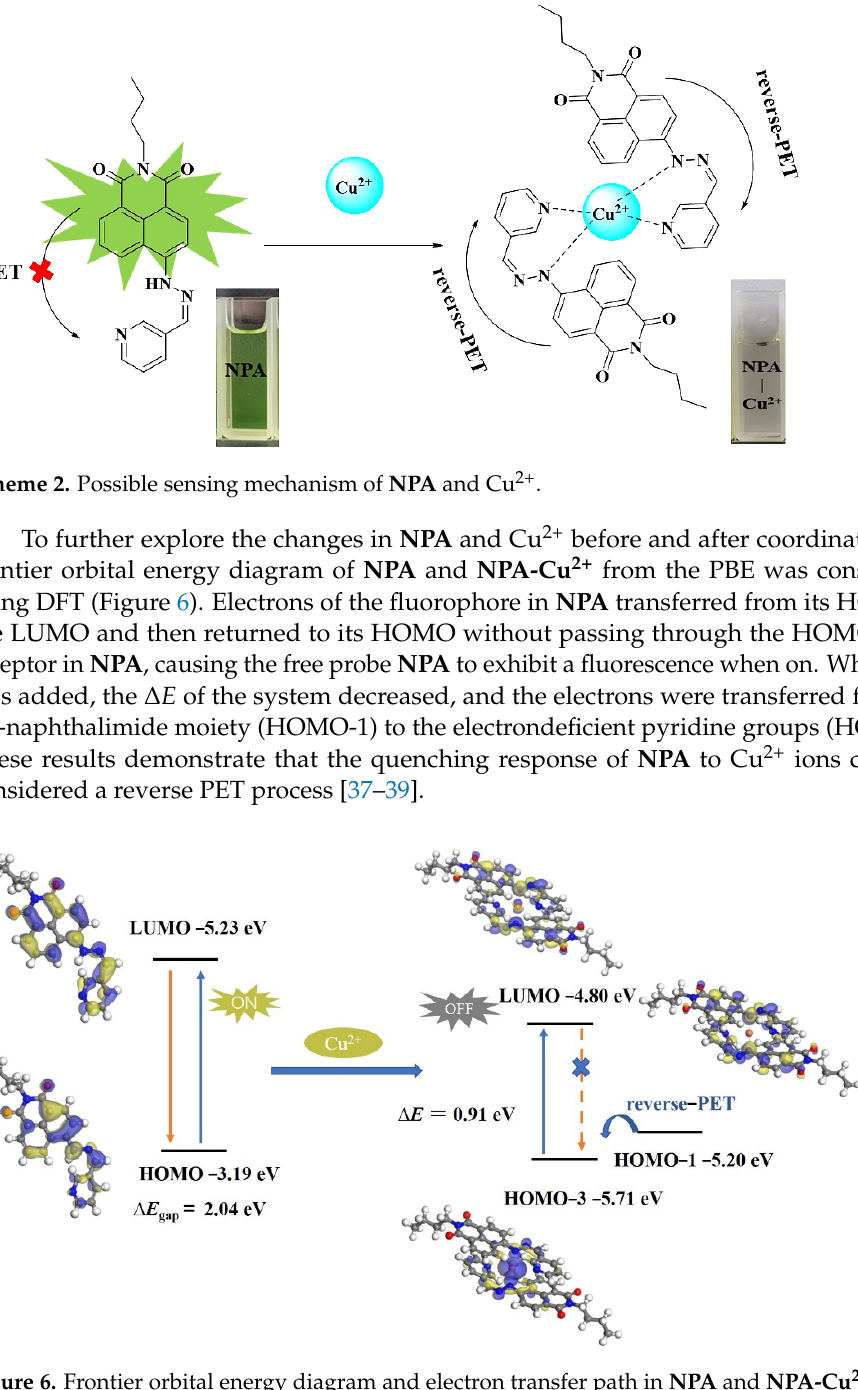
Figure 6. Frontier orbital energy diagram and electron transfer path in NPA and NPA−Cu 2+ .